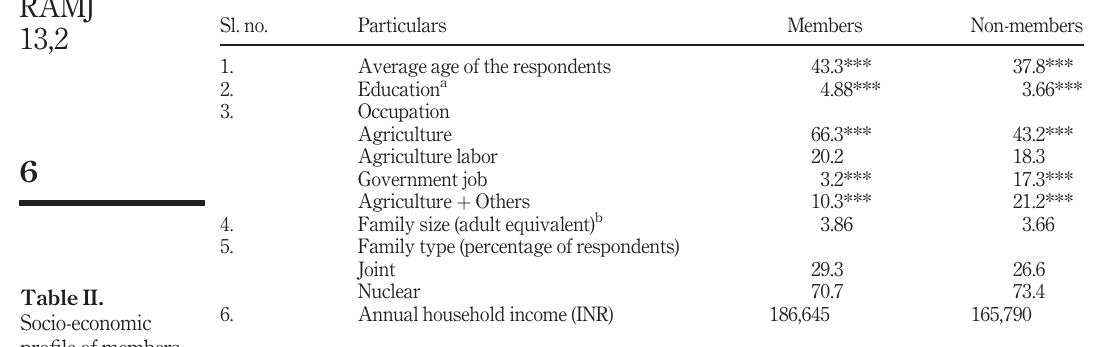
pro fi le of members and non-members of SHGs